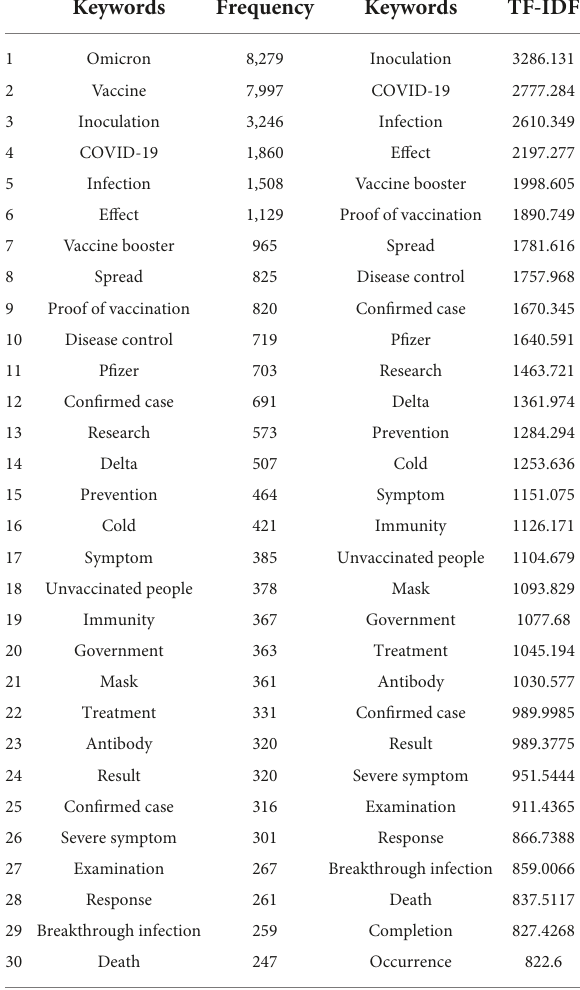
TABLE 1 Results of frequency analysis of top 30 keywords and